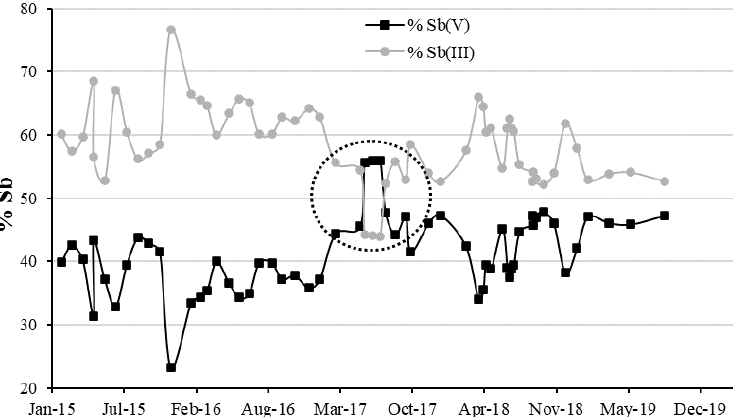
Figure 3. Percentages of Sb species in copper electrolyte during the period 2015 – 2019. Dashed circle indicates an anomalous period in the distribution of Sb species.